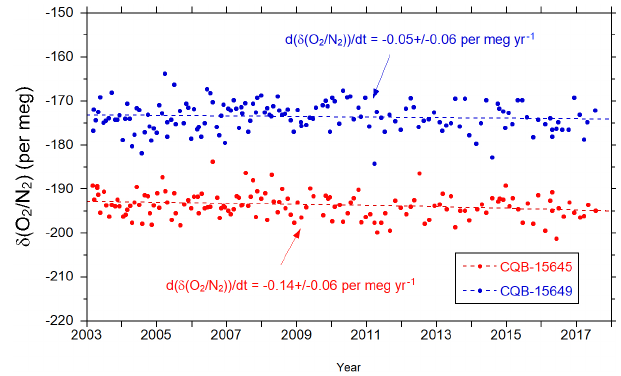
Figure 3. Temporal changes in the O 2 / N 2 ratio of reference airs in two aluminum cylinders which are independent of the NIES pri- mary reference gases, relative to the NIES O 2 / N 2 scale. The dashed lines represent the linear regression